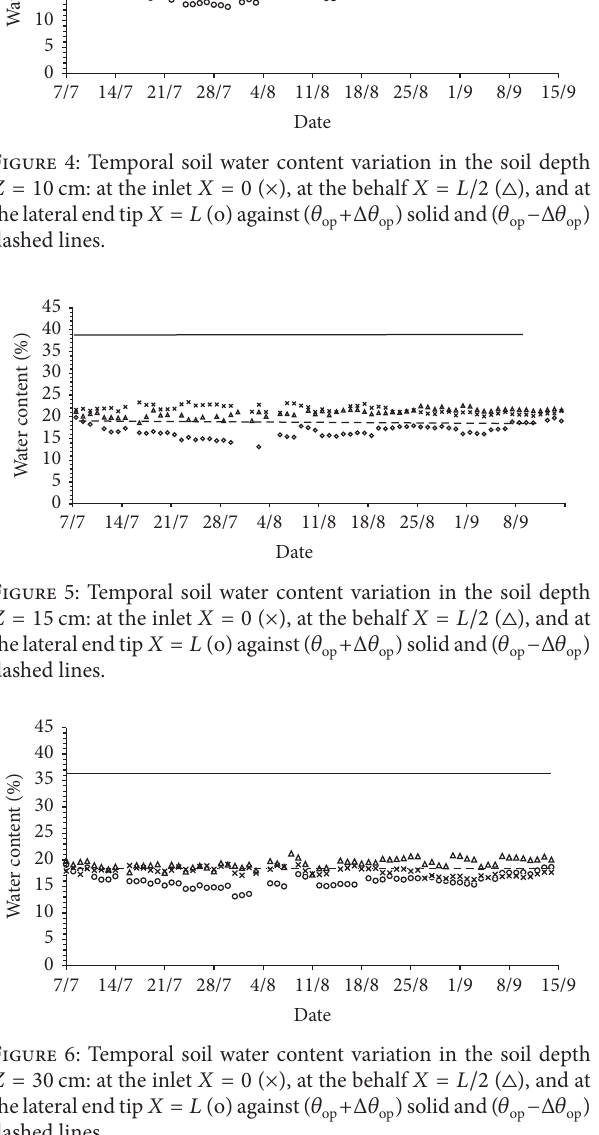
Figure 9: Temporal soil suction variation around the inlet 𝑋 = 0 +Δ𝜃 −Δ𝜃 ) solid and ( 𝜃 ) ( × ), the behalf 𝑋 = 𝐿/2 ( 󳵻 ), and the lateral end tip 𝑋 = 𝐿 (o) op op op op compared to the minimum (dashed line) and the maximum (solid line) required